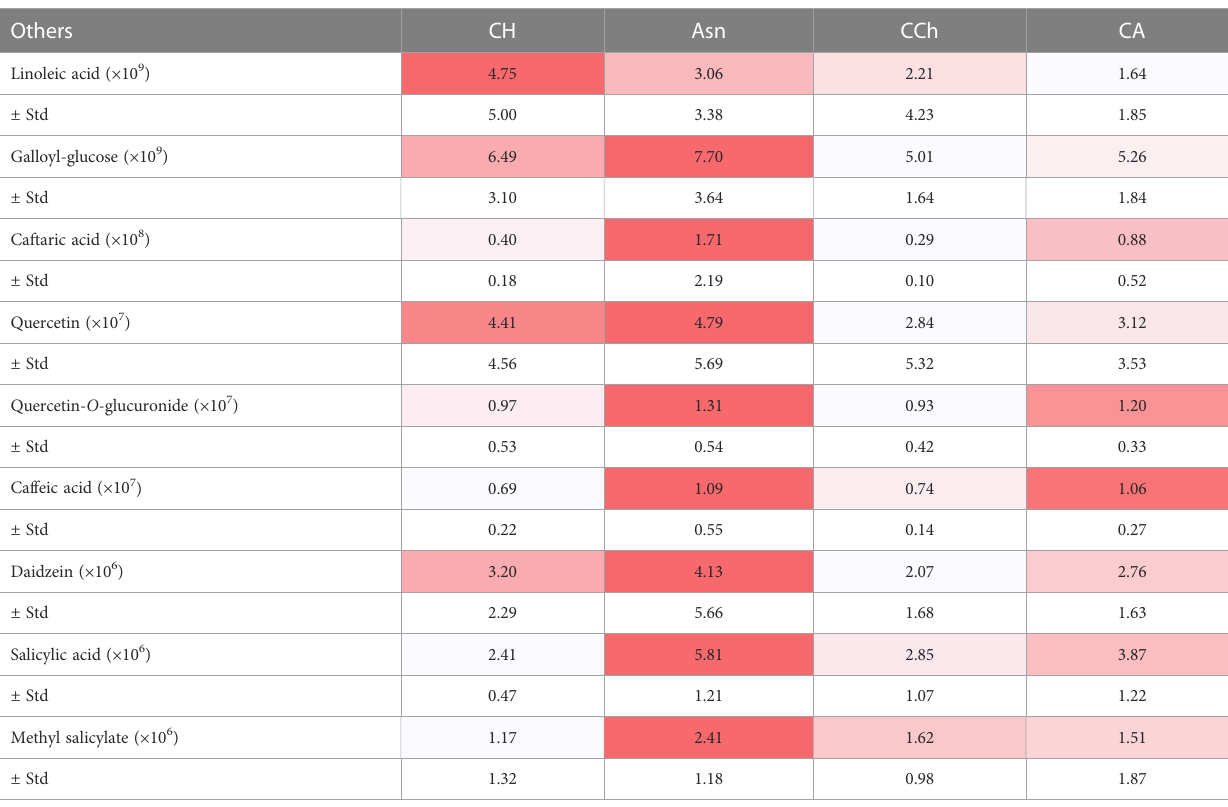
TABLE 3 Amounts of targeted other secondary metabolites in wood samples (WH, WS, and WI) in asymptomatic (healthy (CH) and sodium arsenite-treated (Asn)) and symptomatic (chronic form of the disease (CCh) and apoplectic (CA)) grapevines.